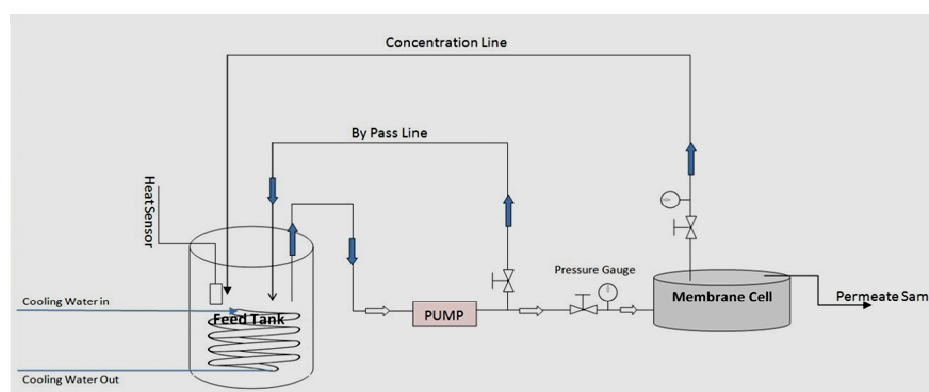
Figure 1. Schematic diagram of the membrane system used in this study